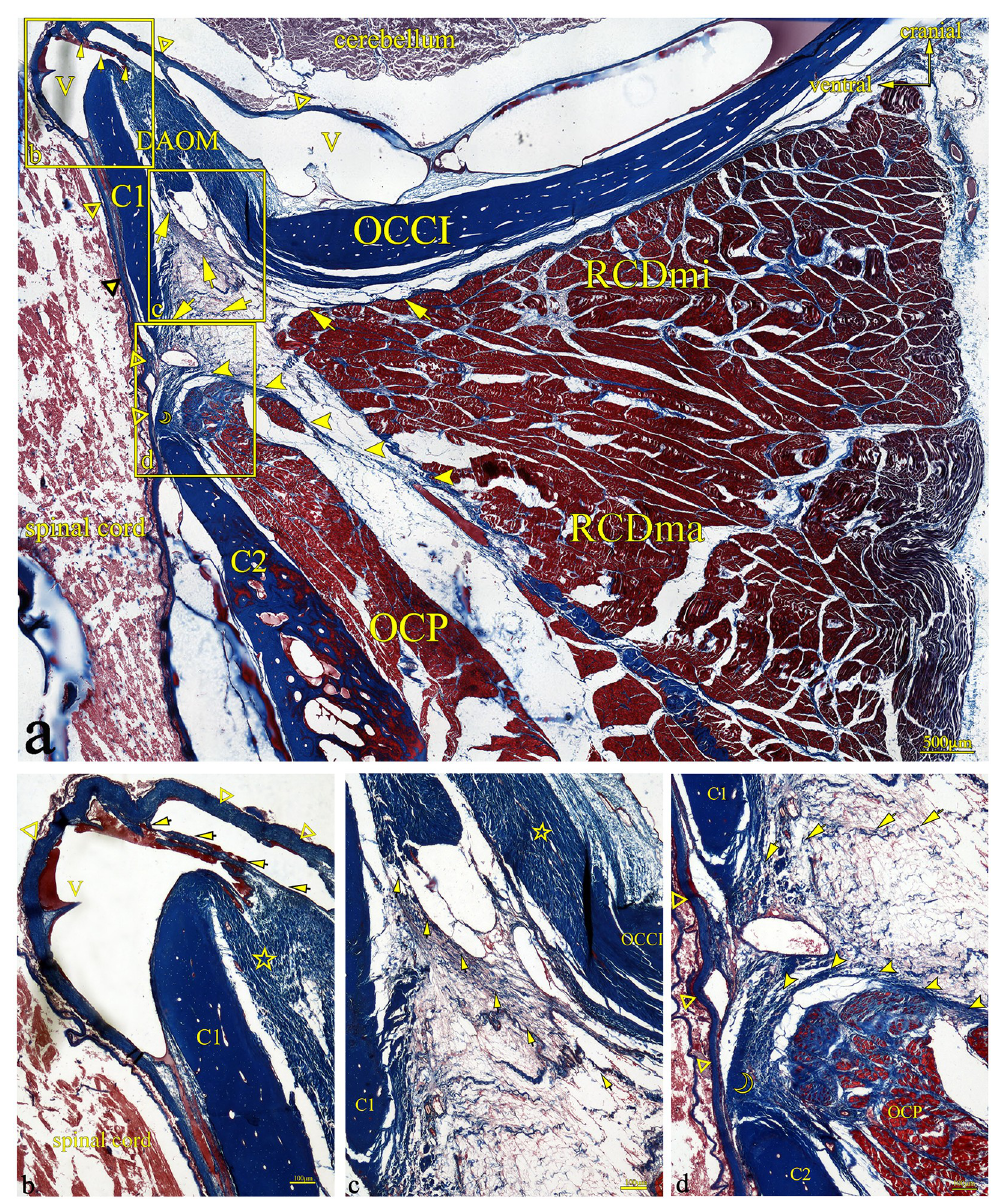
Fig 4. Gentoo penguin, prepared sagittal section of the suboccipital region with stained with Masson. Area within square in a is shown enlarged in b, c, and d. The fibers (arrow) originate from the ventral anterior of RCDmi, extend directly into the atlanto-occipital interspace, then fuse with the DAOM, and the DAOM extends into a fiber bundle through the venous sinus to connect with the SDM (hollow triangle). In the atlanto-axial interspace, the dense fibers bundles (arrow) originating from the ventral side of the RCDmi run ventrally, and integrate into the dorsal atlanto-axial membrane (hollow crescent) together with the dense fibers(filled arrowhead) originating from the RCDma and OCP, and send out dense fibers bundles to closely connect with the SDM. Abbreviation: OCCI = occipital bone; RCDmi = rectus capitis dorsalis minor muscle; OCP = oblique capitis posterior; DAOM = dorsal atlanto-occipital membrane; SDM = spinal dura mater; C1 = atlas; C2 = axial; V = venous